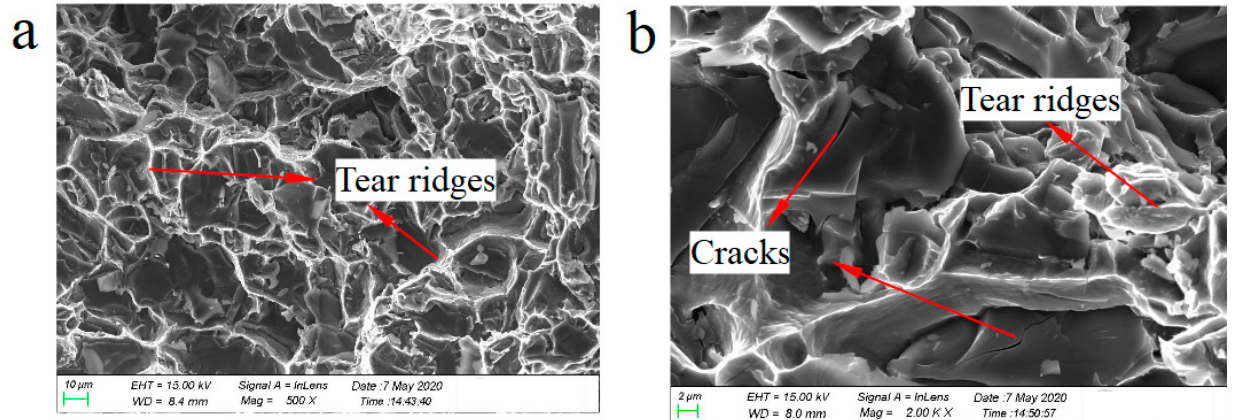
Figure 10. Tensile creep fracture surfaces of the Al–12Si alloy at different magnifications fractured at 350 °C and 70 MPa: ( a ) lower magnification; ( b ) higher magnification.